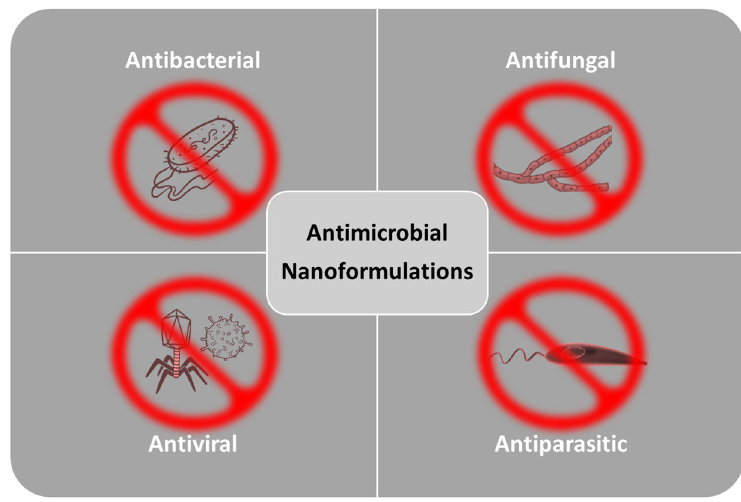
Figure 2. Antimicrobial nanoformulation possibilities.